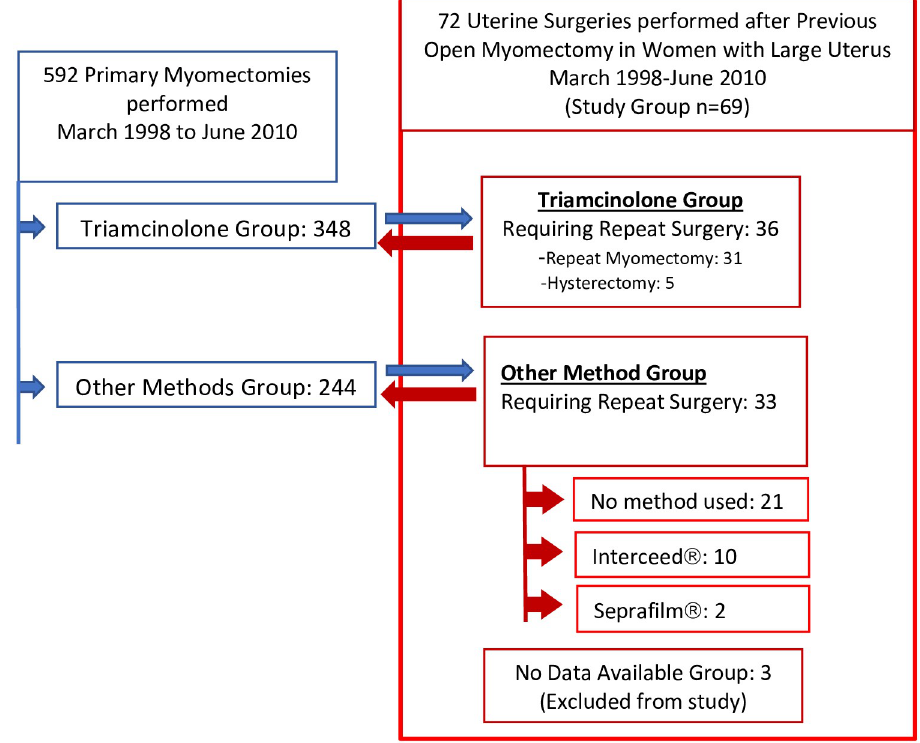
Fig 1. Summary of study cohort. Our cohort consisted of 72 patients who underwent reoperation for a recurrence of symptoms attributable to fibroid uterus after having undergone a primary abdominal myomectomy for large myomas. Data was available on n = 69